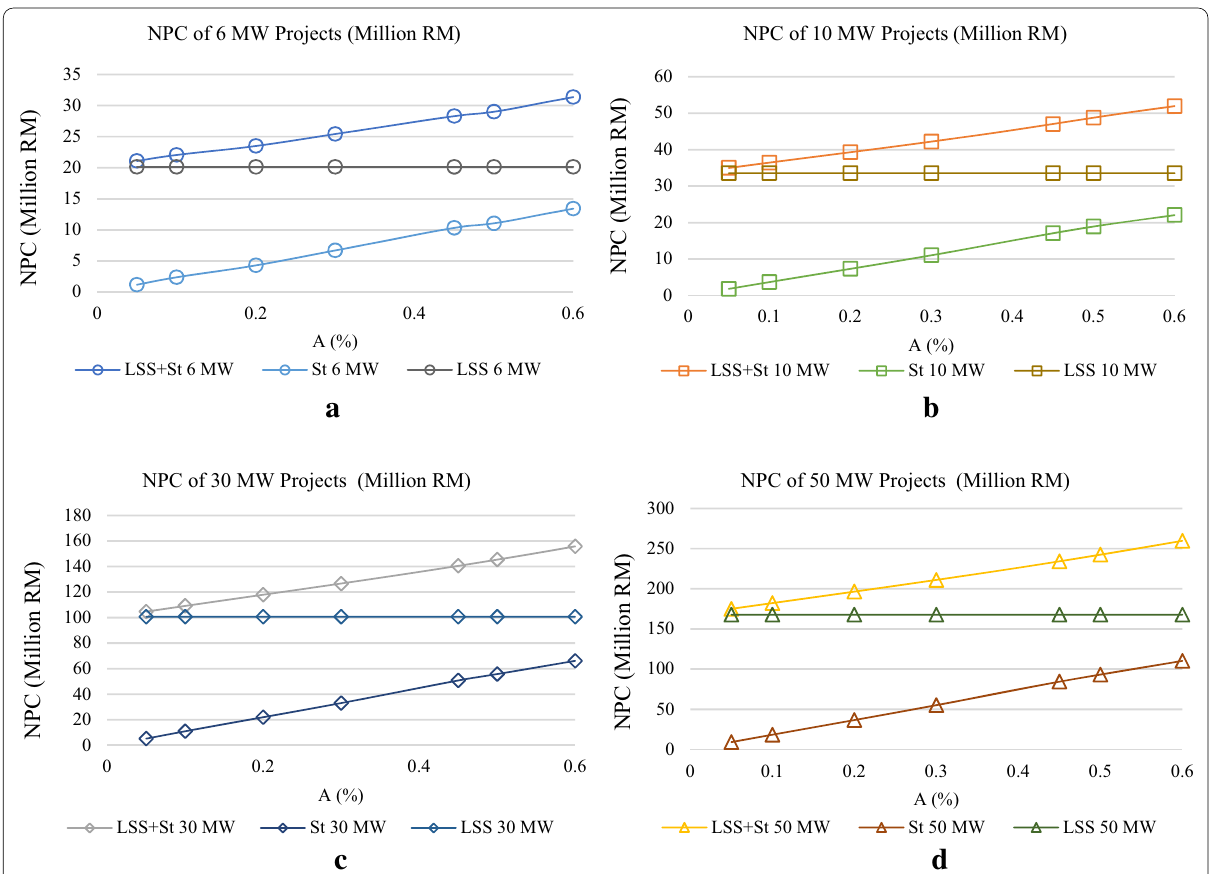
Fig. 6 Net present cost of the different investment types for each LSS capacity. a 6-MW projects, b 10-MW projects, c 30-MW projects, d 50-MW